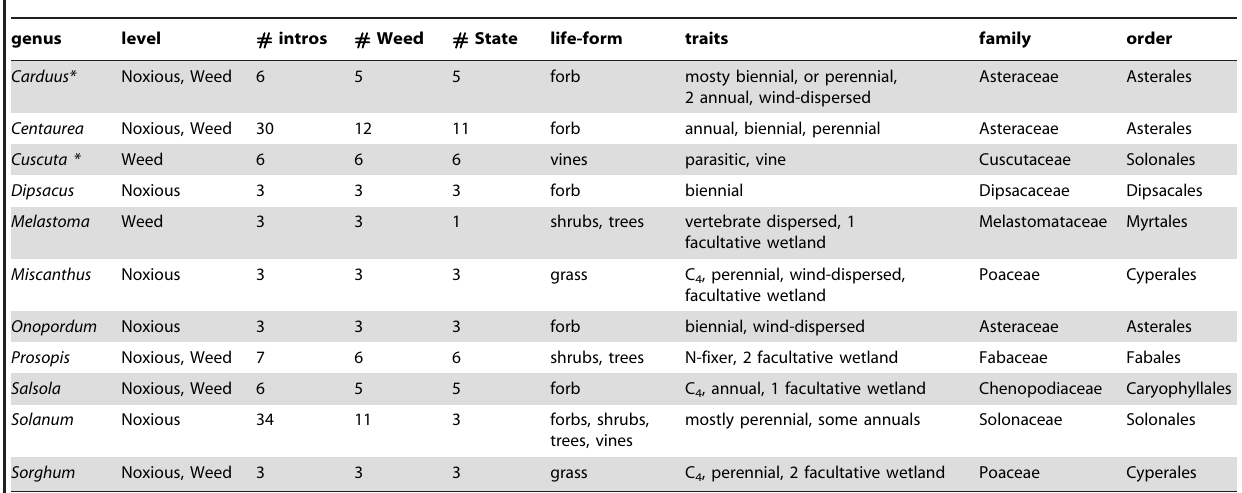
Table 1. Results of contingency table